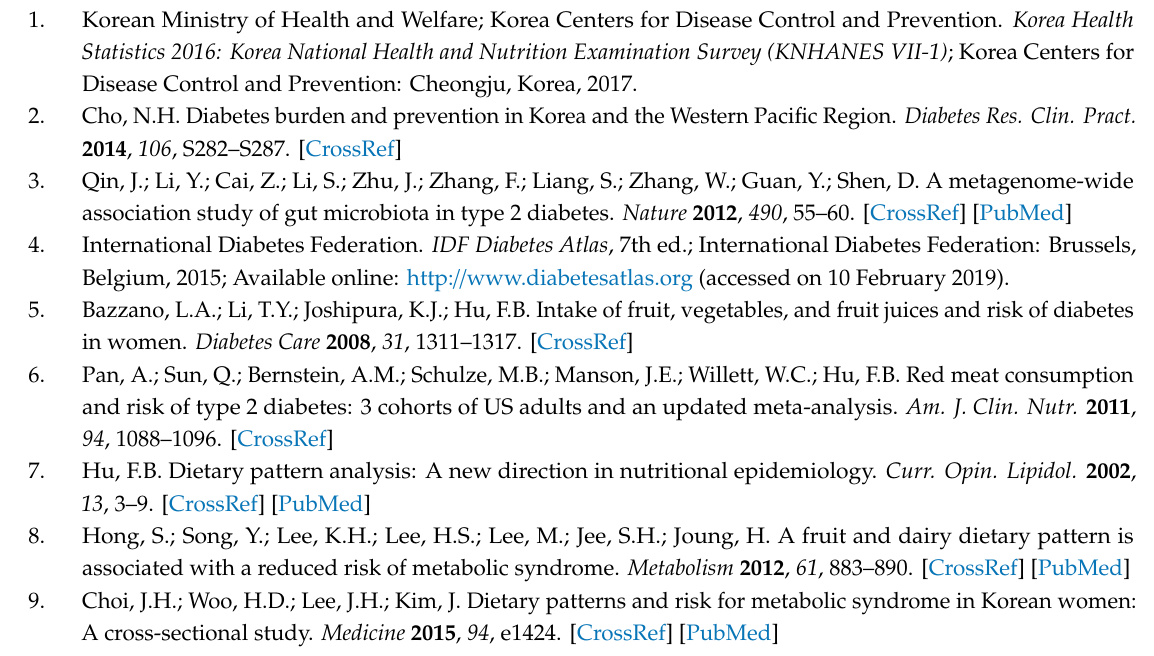
Table S1: Distribution of factor scores across quintiles of each dietary pattern in the middle-aged Korean adults, the KoGES-HEXA